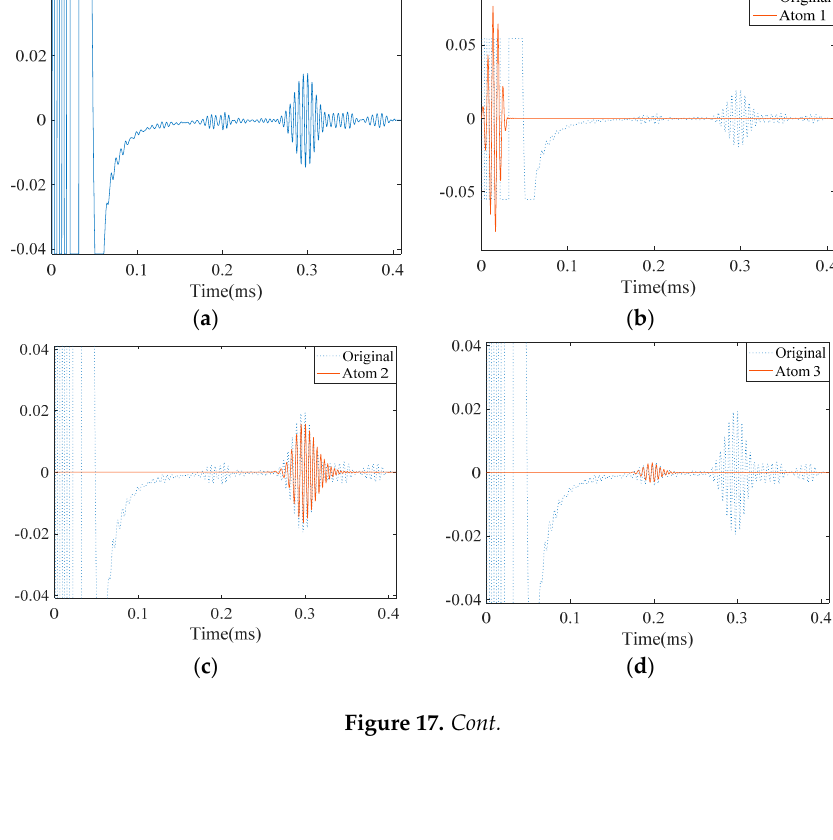
Figure 17. The experimentally measured signal in a pipe with two cracks and its approximation by SDMP: ( a ) the originally measured signal; ( b ) approximated atom 1—the incident signal; ( c ) approximated atom 2—the reflection from the pipe end; ( d ) approximated atom 3—the reflection from the first crack; and ( e ) approximated atom 4—the reflection from the second crack. For the purpose of comparison, we applied MP with a Gaussian dictionary to the same signal. As can be seen in Figure 18, the first atom, similarly other study cases, approximates the incident signal at the location of the sensor. The reflection from the pipe end takes place as the third atom which is similar to the case of the pipe with one crack. However, as these two approximations were poor, MP tries to improve the representation by selecting more irrelevant atoms that do not have physical meanings. We let the MP continue its iteration and, as a result, the first defect signal appeared as the 664th atom. The reflection from the second crack could have emerged if we had further pursued the iterations in MP. However, this result clearly demonstrates how the SDMP enhances the performance of the guided wave signal representation.